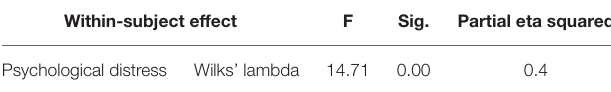
TABLE 1 | Descriptive statistics ( n = 73). TABLE 2 | Within-subject effect for time on psychological distress.